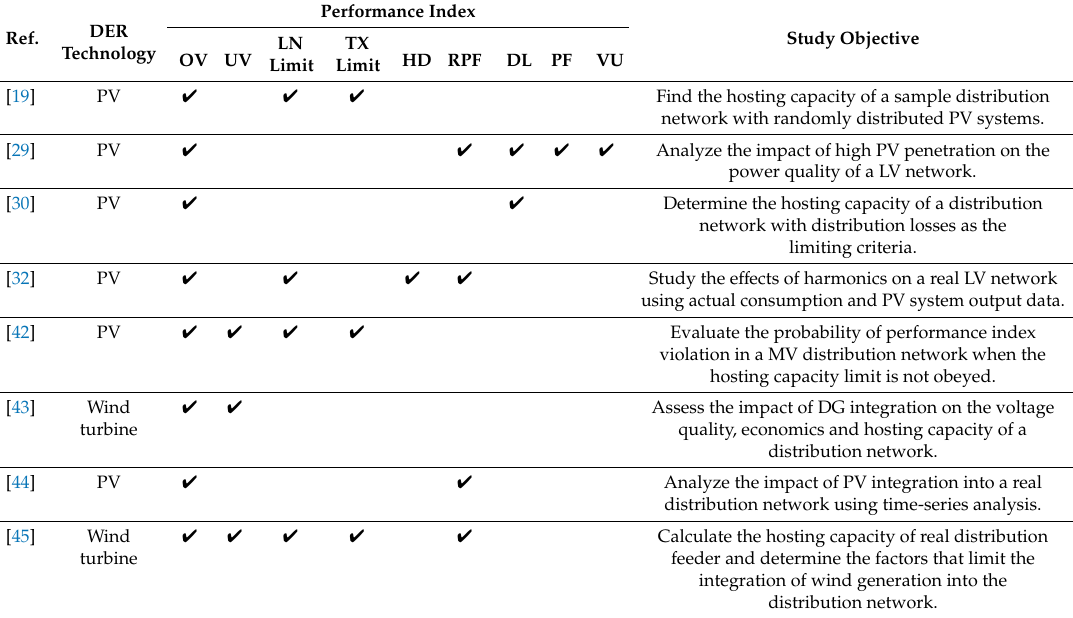
Table 2. Studies that utilize the time series method for hosting capacity evaluation.